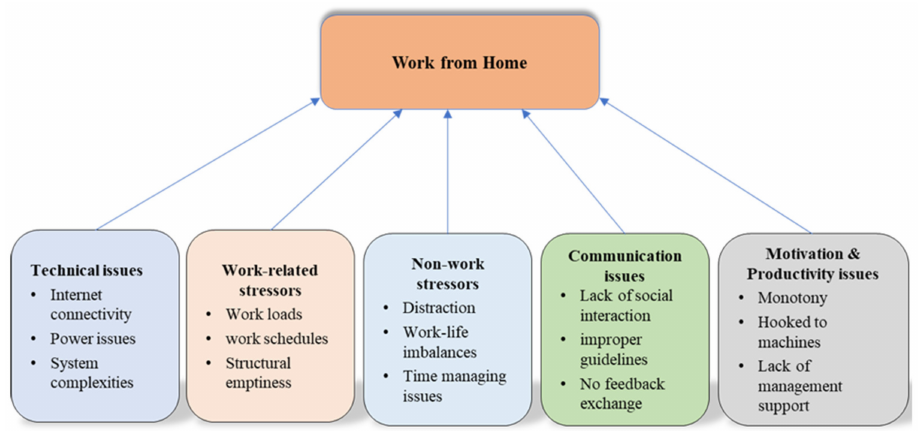
Figure 1. Factors affection